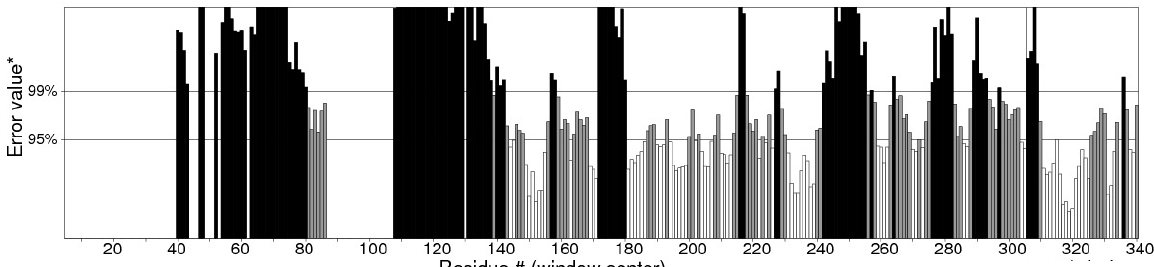
Figure 3. Quality estimation of modeled protein structure. * On the error axis, two lines are drawn to indicate the confidence with which it is possible to reject regions that exceed that error value.